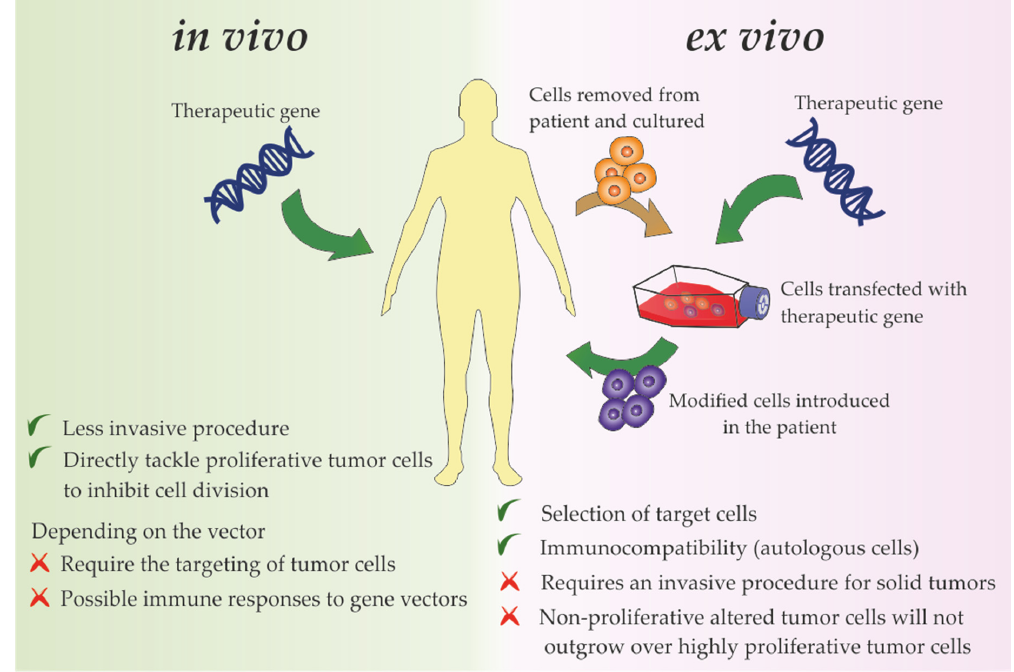
Figure 1. Delivery strategies used for gene therapy directly targeting tumor cells or tumor microenvironment components, their major advantages (preceded by a green checkmark) and disadvantages (preceded by a red